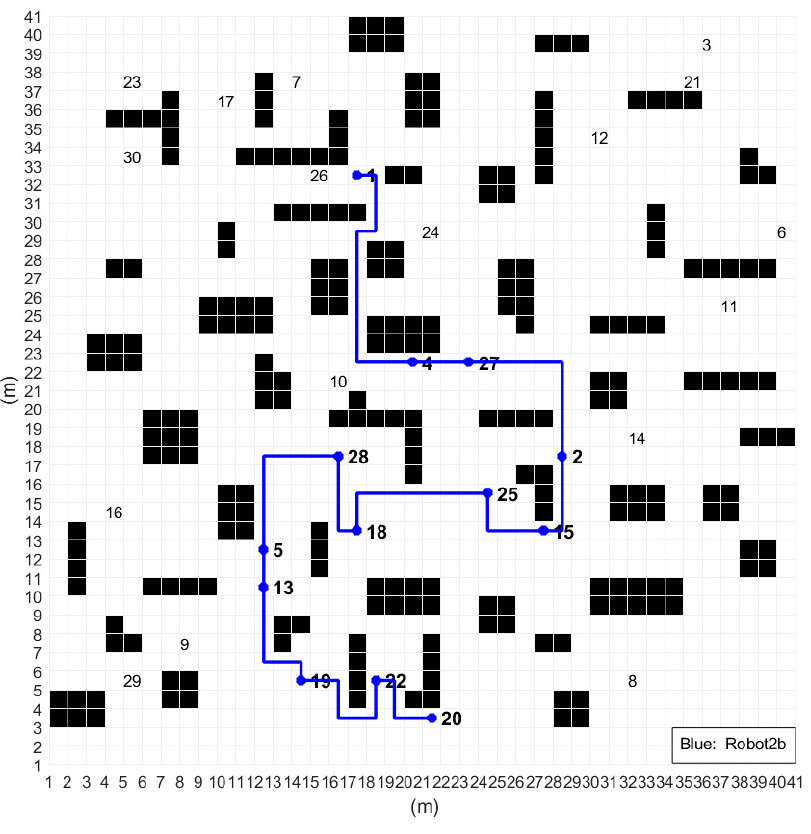
Figure 17. Path planning diagram of Robot 2 after task sequence optimization from Experiment 5. Table 8. The optimal task sequence and operation parameters of Robot 2 from Experiment 5.